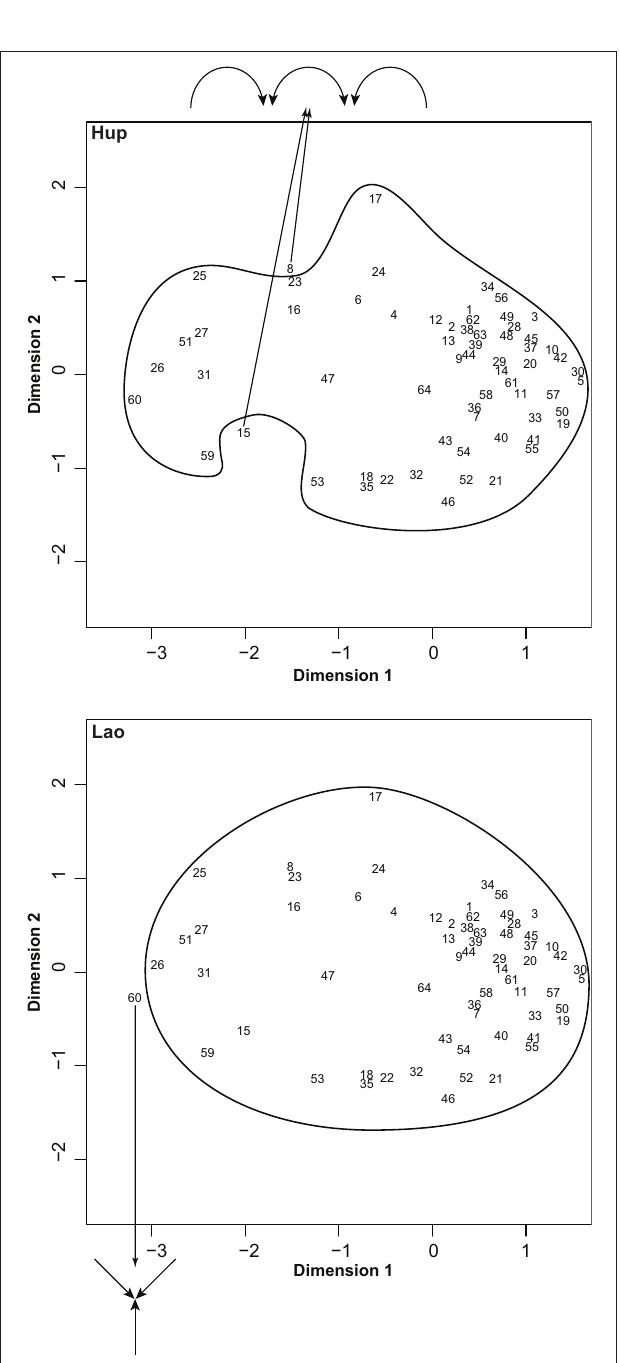
FigurE 6 | Extensional range for Hup (top) and Lao (bottom) constructions.